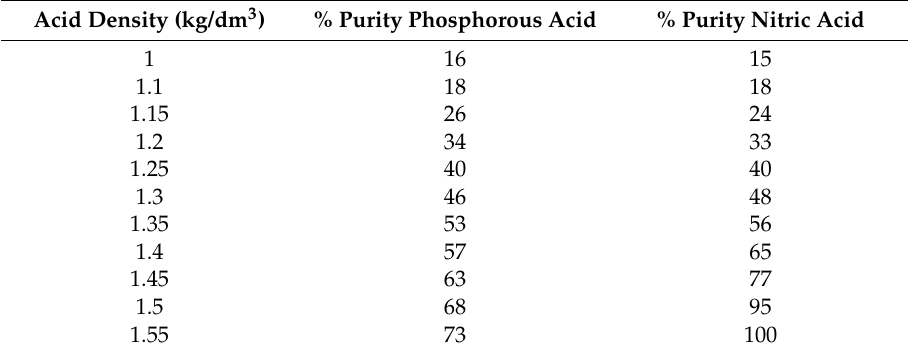
Table 1. Values of acid density and purity of the two acid types in our